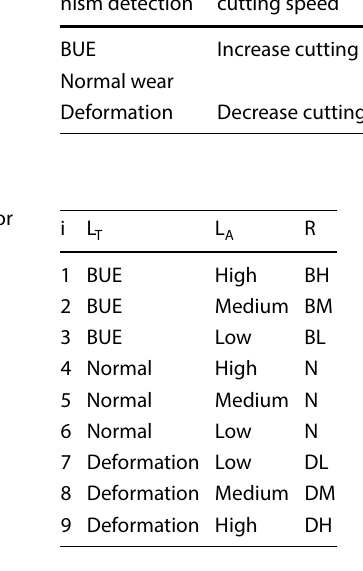
Table 2 Remedy actions from knowledge base troubleshooting guides published by tool manufacturers